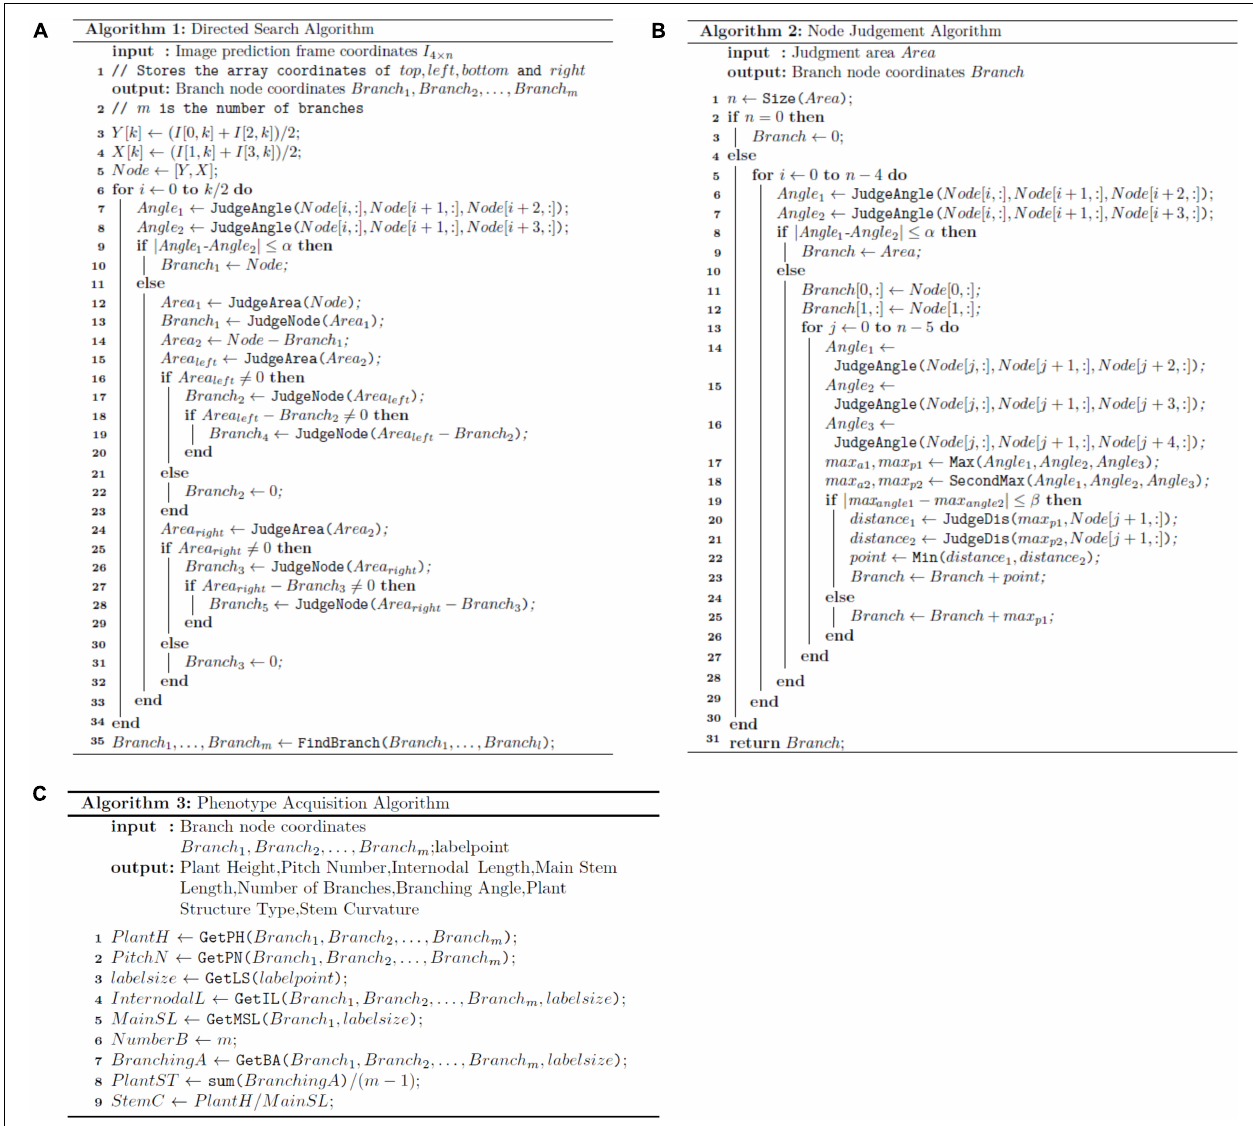
FIGURE 4 | Pseudo-code: (A) directed search algorithm, (B) node judgment algorithm, and (C) phenotype acquisition algorithm.